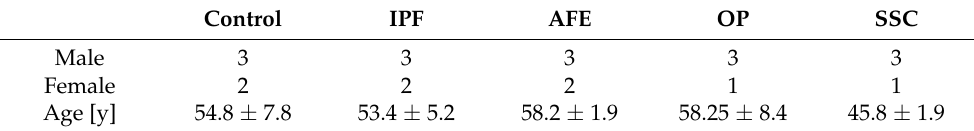
IPF: idiopathic pulmonary fibrosis, AFE: alveolar fibroelastosis, OP: organizing pneumonia, SSC: systemic